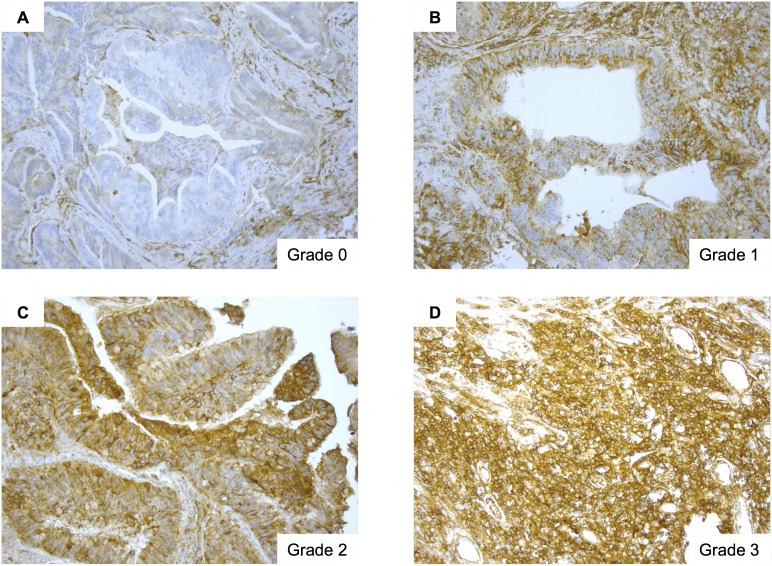
Human leukocyte antigen (HLA) class I expression in tumor cells.Representative images showing HLA class I expression by rectal cancer cells. A, Grade 0 expression. B, Grade 1 expression. C, Grade 2 expression. D, Grade 3 expression. Magnification, ×200.